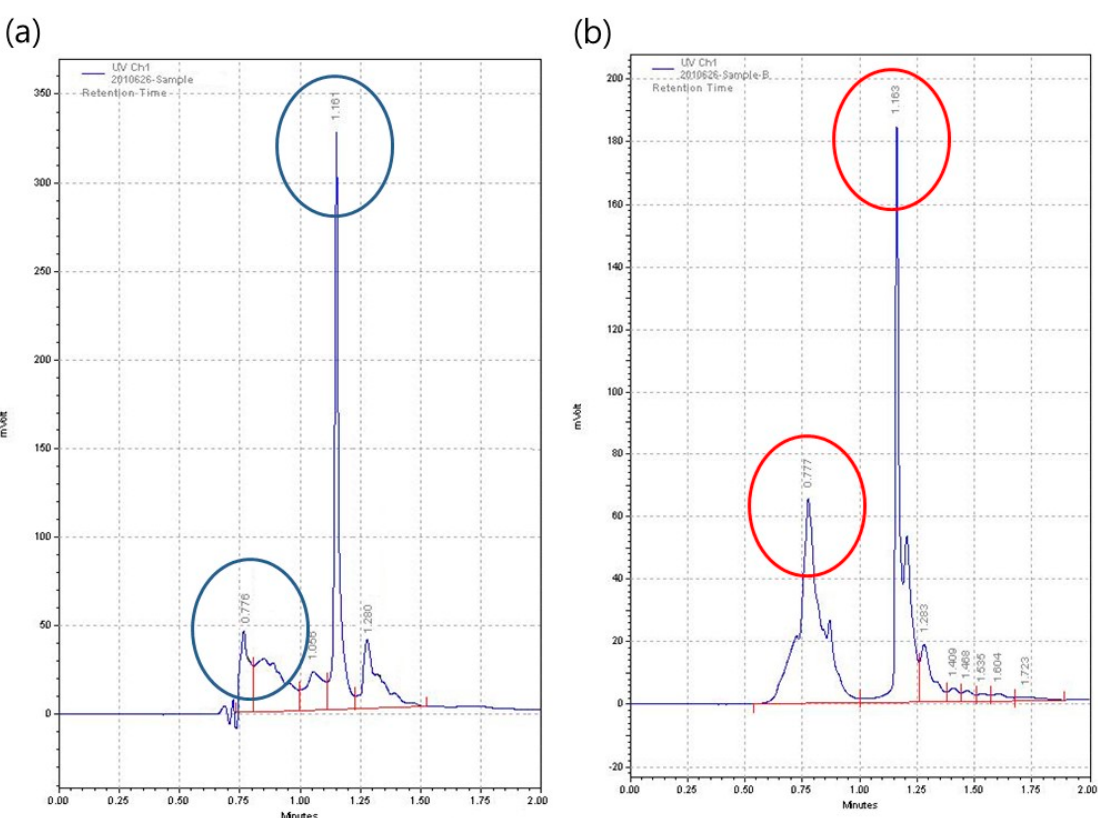
Figure 6. HPLC peaks of ( a ) methylglyoxal (MGO) and ( b ) chestnut honey (CH).